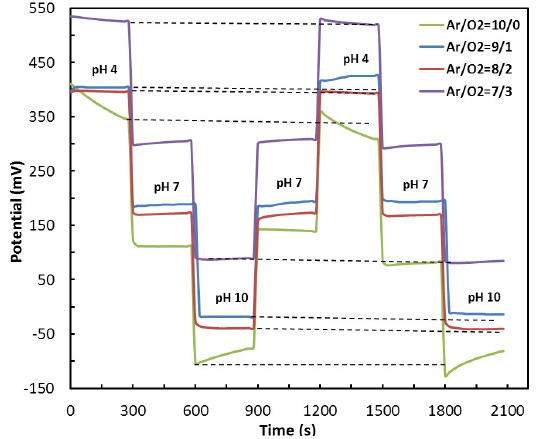
Figure 5. Measured average potential versus time when the pH of the solution is sequentially switched between pH 4, pH 7 and pH